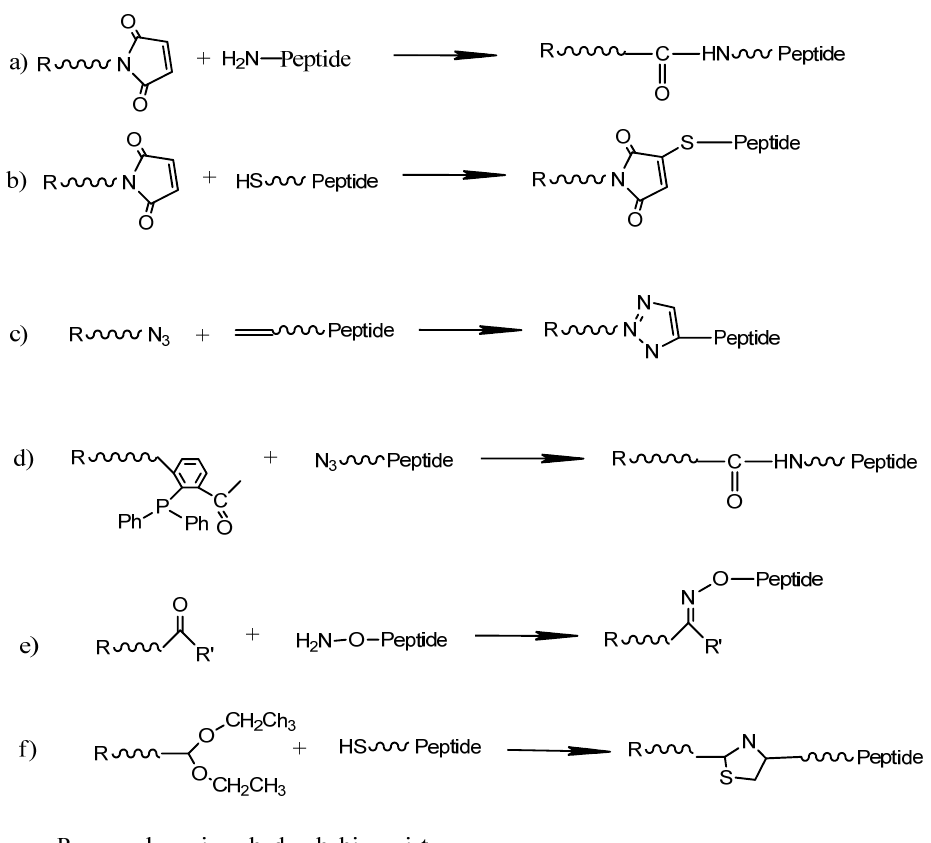
Scheme 1. Chemical reactions for peptide coupling: ( a ) amine- N -hydroxysuccinamide coupling